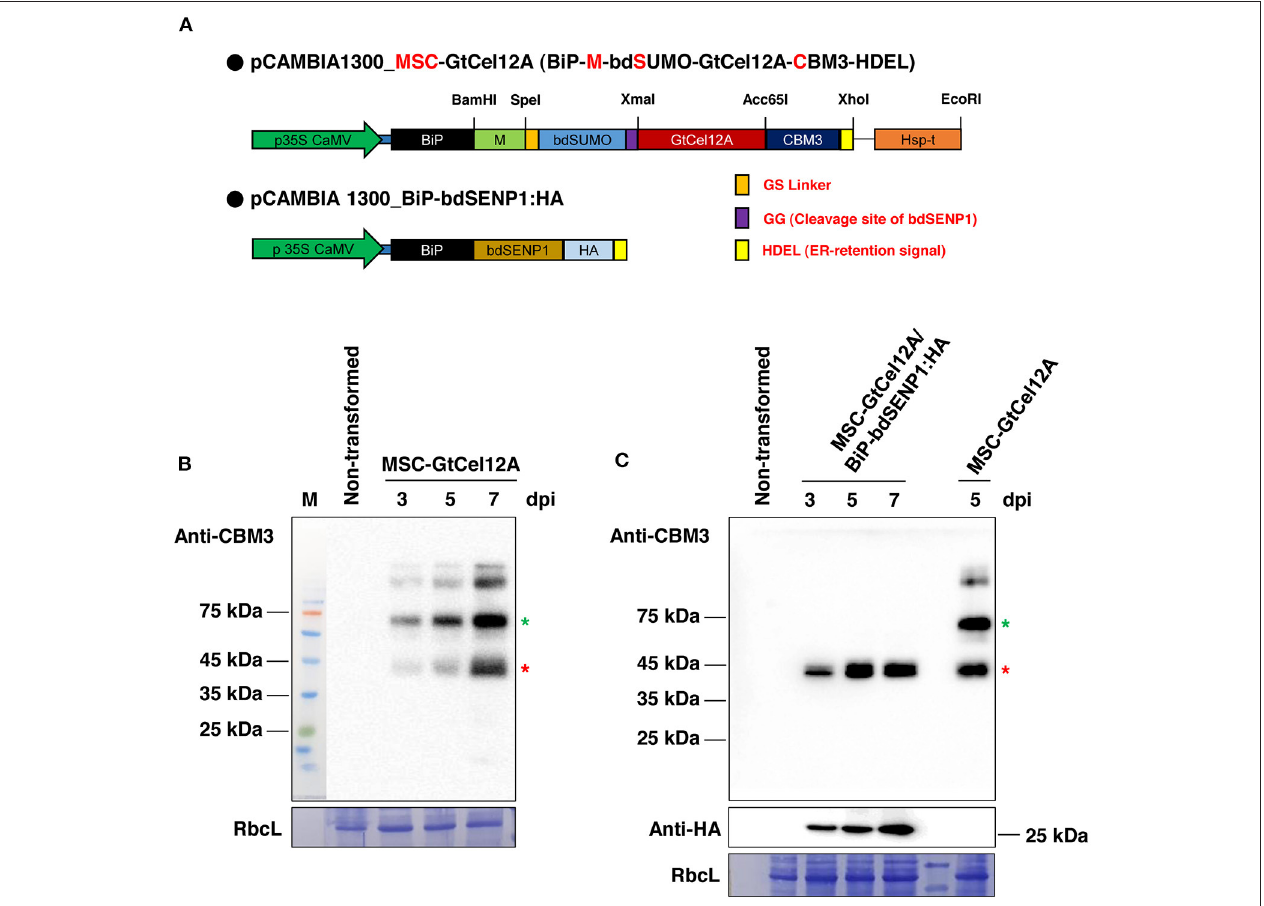
FIGURE 1 | Transient expression of MSC-GtCel12A in Nicotiana benthamiana . (A) Schematic representation of MSC-GtCel12A and BiP-bdSENP1:HA . BiP, the signal sequence of BiP; M, the extracellular domain (amino acid residues 231–290) of human protein tyrosine phosphatase receptor type C; bdSUMO, the SUMO domain of Brachypodium distachyon ; CBM3, the cellulose-binding module 3 of Clostridium thermocellum ; HDEL, ER retention signal. (B,C) Expression of MSC-GtCel12A in N. benthamiana . The leaf tissues of N. benthamiana were infiltrated using a syringe with A. tumefaciens harboring the indicated constructs. A. tumefaciens harboring P38 were co-infiltrated in every agroinfiltration. The transformed leaves were harvested 3, 5, and 7 days post-infiltration (dpi), followed by total protein extract preparation. Total protein extracts (20 µ g) were analyzed by western blot analysis using anti-CBM3 or anti-HA antibodies. RbcL, large subunit of the Rubisco complex stained with Coomassie Brilliant Blue